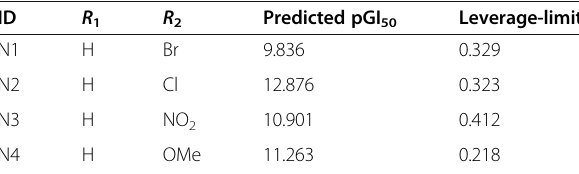
Table 2 Structural modification of compound 39 and predicted pGI 50 with leverage